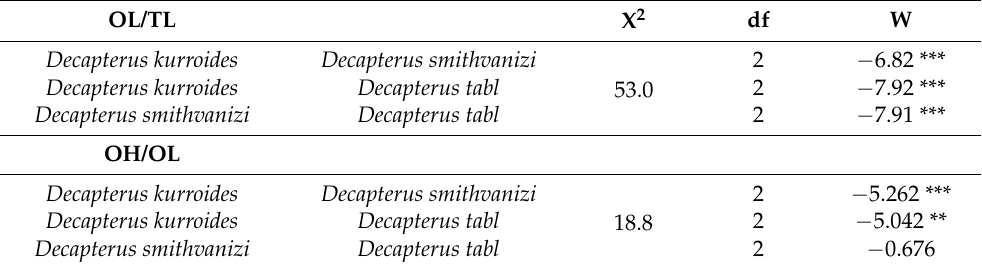
D. tabl, OL/TL were 2.52 ± 0.12% and 1.88 ± 0.44%, respectively. For OH/OL, values were 45.46 ± 3.34% in D. kurroides , 46.6 ± 2.40% in D. smithvanizi , and 42.29 ± 1.53% in D. tabl .